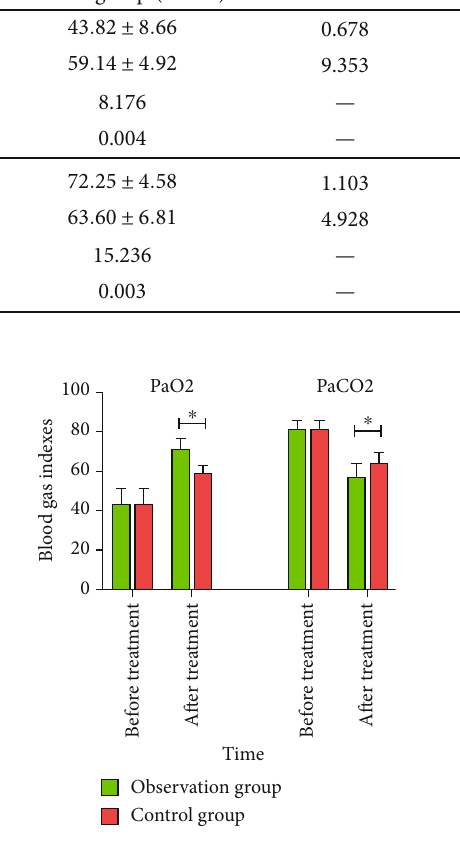
Figure 2: Comparison of blood gas index level between the observation group and the control group before and after treatment. Note: compared with the control group through “ t -test, ” ∗ P < 0 : 05